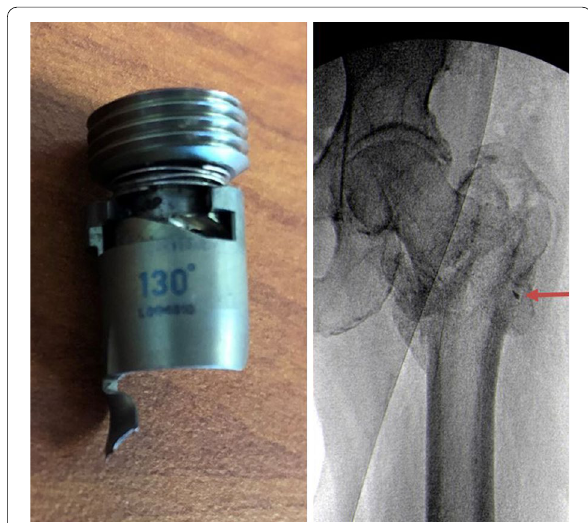
Fig. 7 Visualized on the left is the characteristic deformity and fracture of the TFNa set screw that occurs if the lock prong is damaged during implant extraction. Failure to fully elevate the set screw prior to helical blade removal will cause the lock prong to deform and fracture more distally toward its tip. The fractured lock prong in this case remained within the patient as a retained foreign body visible on X-ray marked by the arrow in the image to the right